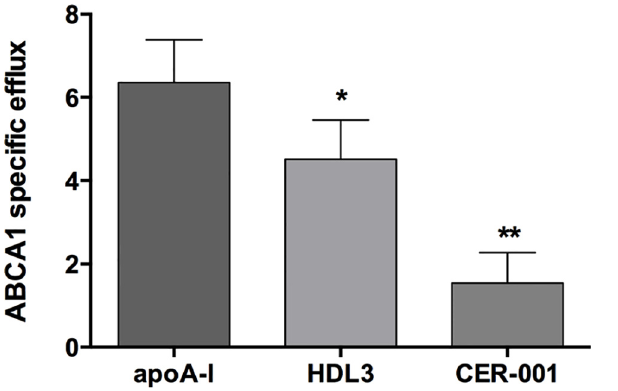
Fig 3. cAMP stimulated-ABCA1 specific efflux decrease in J774 macrophages following CER-001 and HDL3 incubation. J774 macrophages were incubated with cAMP to increase the ABCA1 expression and then CER-001 and HDL3 at 25 μ g/ml were added in the cell culture medium and the specific cAMP cholesterol efflux was determined. apoA-I (25 μ g/ml) was used as reference for specific ABCA1-cholesterol efflux in the experiment. ** p < 0.01, *** p <